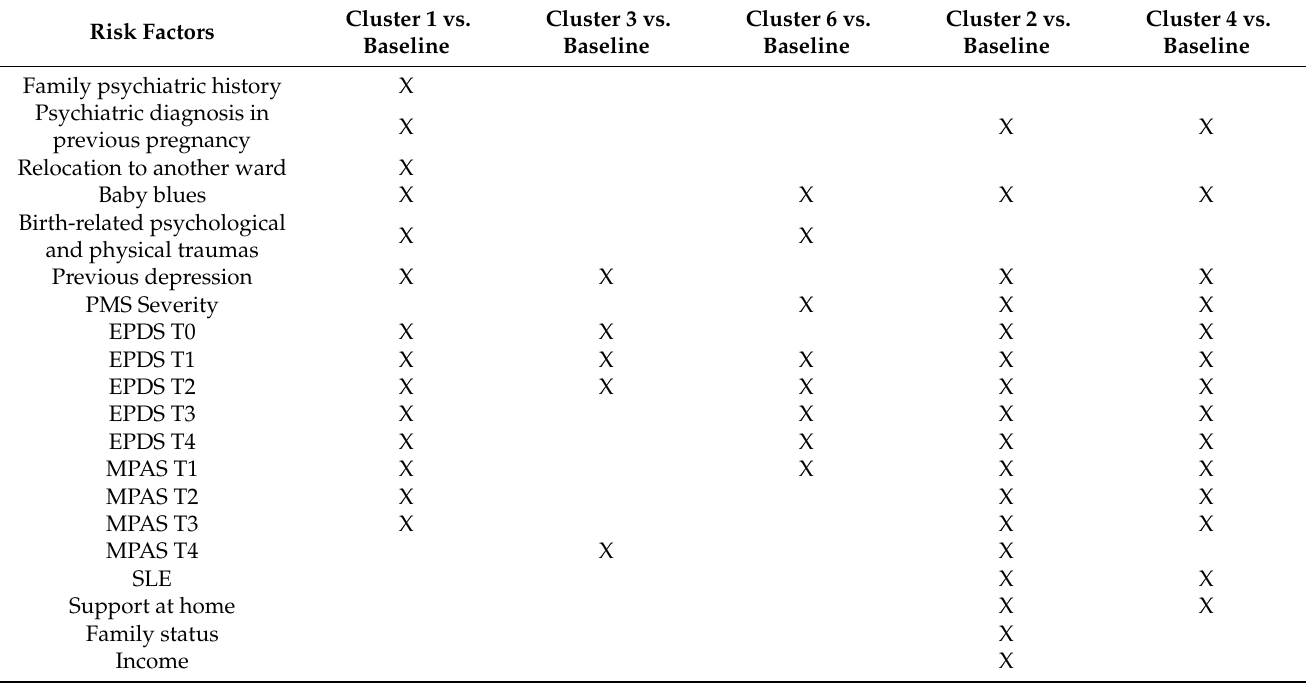
Table 1. Comparison of risk factors between the recovering, deteriorating, and baseline